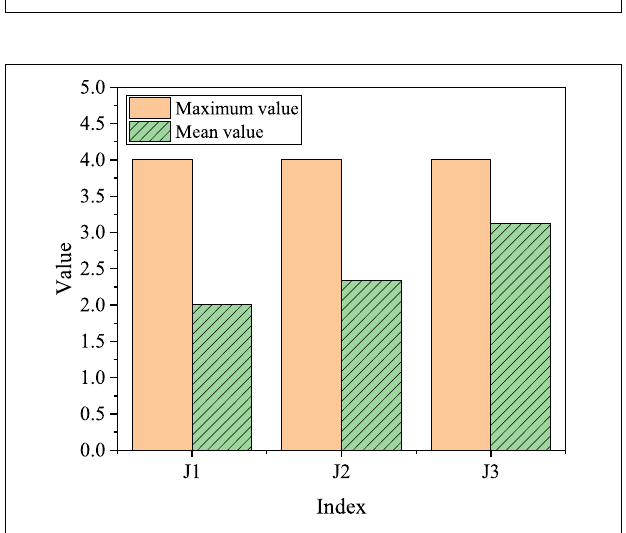
FIGURE 11 | Evaluation and statistics of college students for entrepreneurship support from